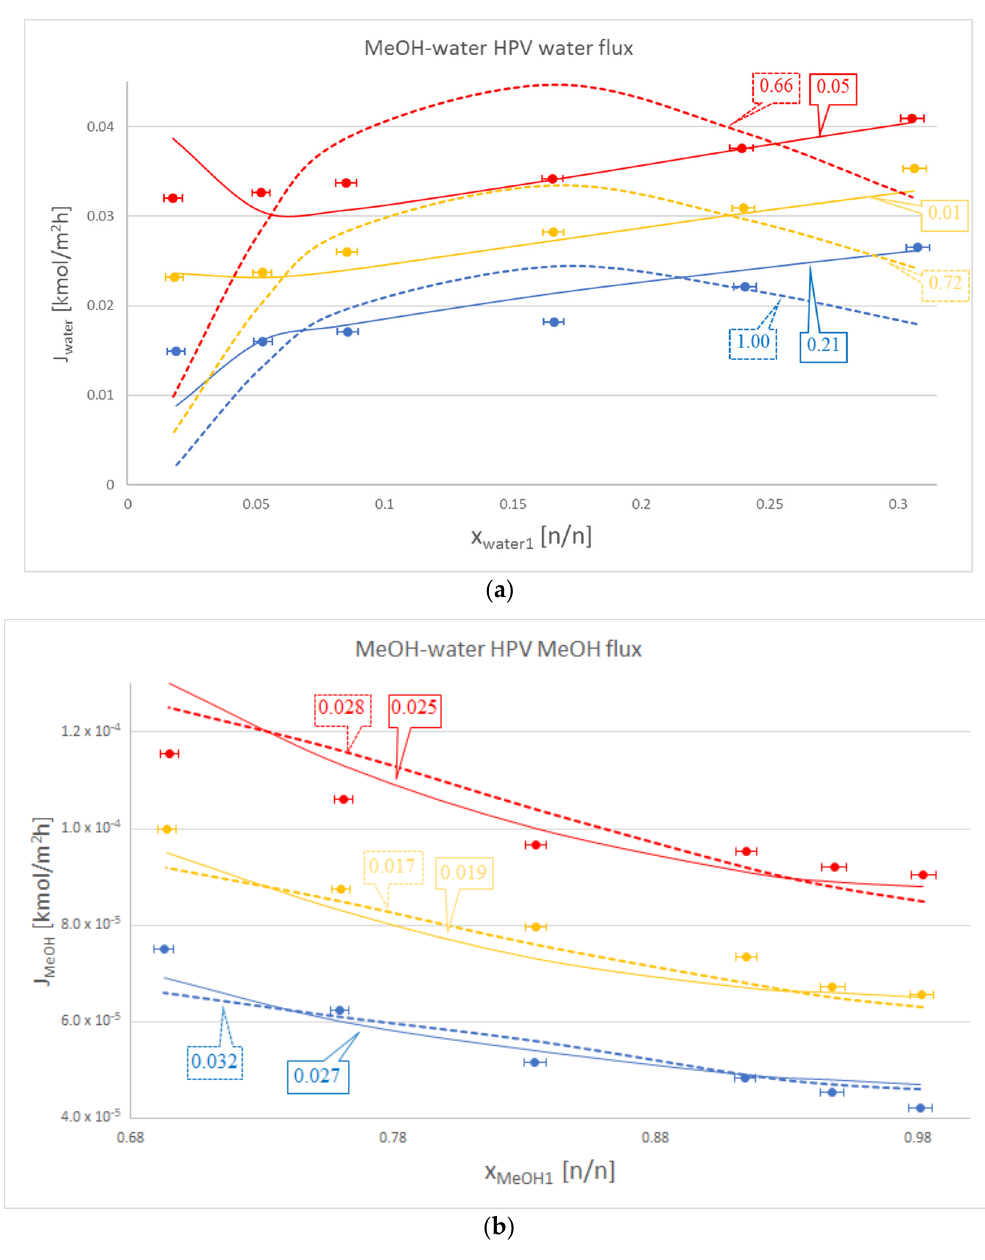
Figure 2. Comparison of Model I ( - - - ), Model III ( ––– ) and experimental data ( ● ), where the colour code means the following: blue: 50 °C, yellow: 60 °C and red: 70 °C. Objective functions (OFs) are represented in the text bubbles per model per temperature. ( a ) MeOH-water hydrophilic (HPV) water flux; ( b ) MeOH-water HPV MeOH flux.